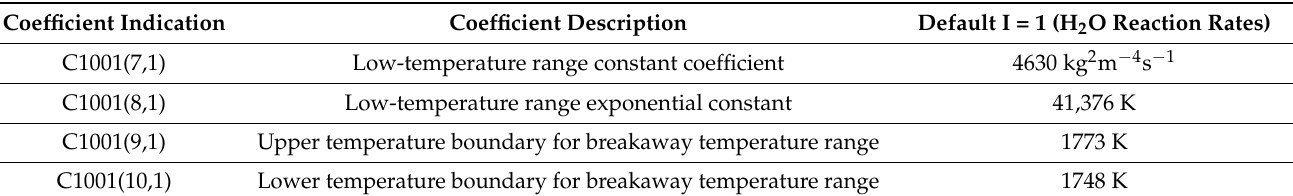
Table 3. Metallic cladding oxidation rate constant for FeCrAl in MELCOR 2.2. 18019 [4].